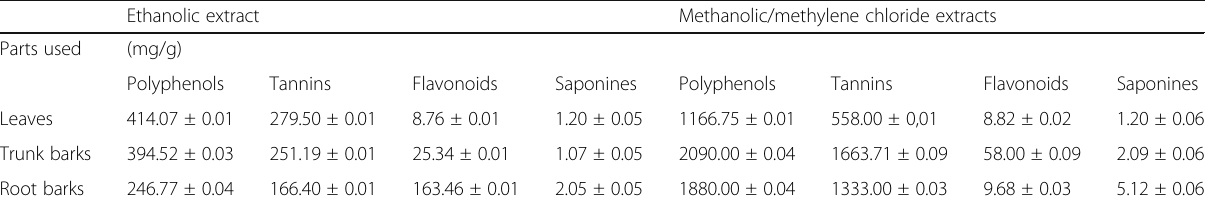
Table 3 Phytochemical screenings of the ethanolic and MeOH-CH 2 Cl 2 extract of leaves, trunk bark and root bark of L. lanceolata . The phytochemical screening revealed the presence of flavonoids, saponins, polyphenols and tannins in leaves, trunk bark and root bark of plants. Data are mean ± SEM from three independent duplicate